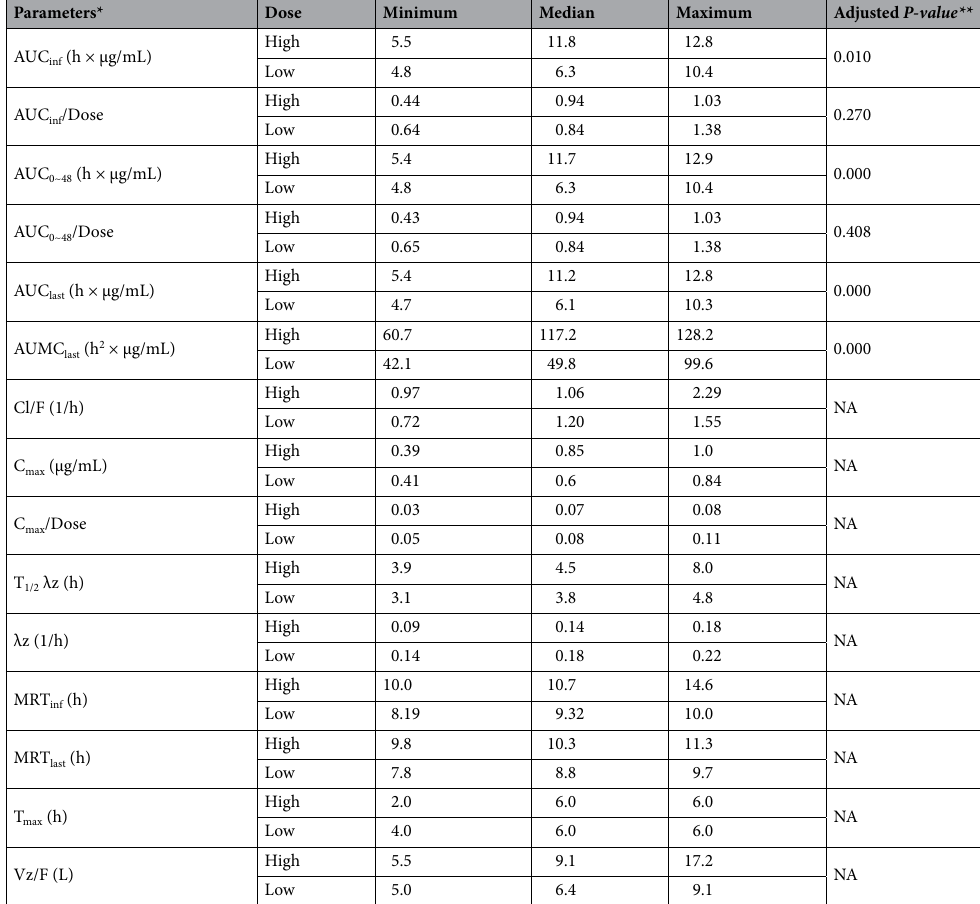
Table 2. The plasma pharmacokinetics of enrofloxacin administered to calves subcutaneously (low dose 7.5 mg/kg, high dose 12.5 mg/kg body weight, 14 animals in each healthy and BRD combined group) computed by a non-compartmental model (i.e., statistical moments) analysis. * PK-parameters area under the curve from the time of dosing extrapolated to infinity (AUC inf ), area under the curve from the time of dosing to the last sampling time point (AUC 0~48 ), area under the curve from the time of dosing to the last measurable positive concentration (AUC last ), area under the first moment curve from dosing to the last measurable concentration (AUMC last ), apparent clearance (CL/F), maximum observed concentration (C max ), mean residence time from the time of dosing to the last measurable concentration (MRT last ), time to the